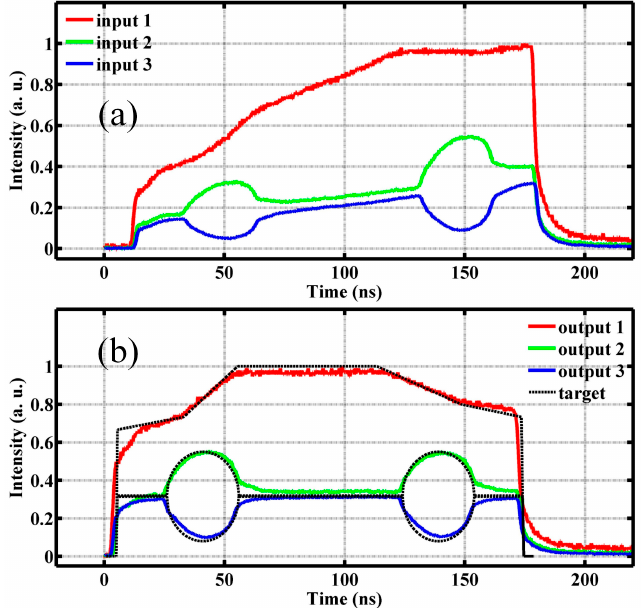
Figure 5. Compensation of the pulse distortion. ( a ) Input pulse shape (three pulses); ( b ) output pulse shape with amplified power.